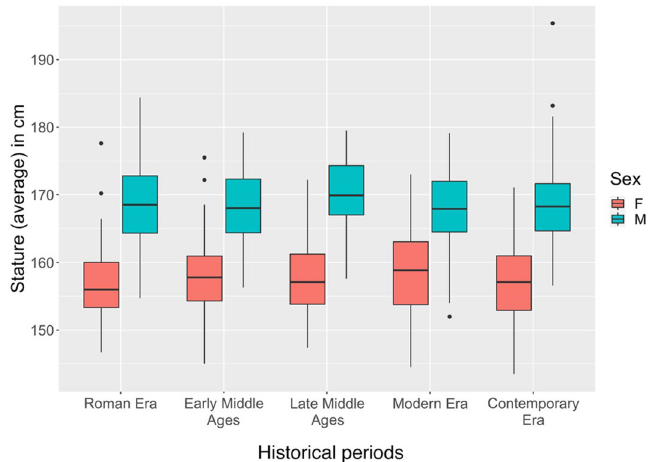
Figure 2. Boxplot visualization of the data according to sex and historical